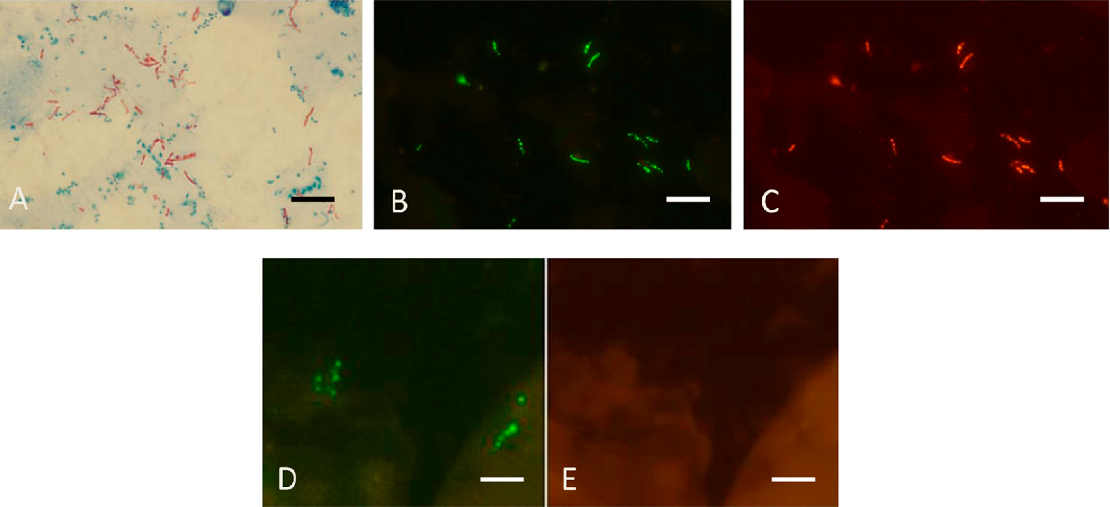
Figure 8. Sputum smears in the MN Genus-MTBC FISH test. Photographs showing dual colour fluorescence reactivity of sputum smears from patients with Mycobacterium tuberculosis and Mycobacterium abscessus infections in the MN Genus-MTBC FISH test. A shows Ziehl–Neelsen staining for acid-fast bacilli in sputum from a patient with Mycobacterium tuberculosis infection. MN Genus-MTBC FISH test results with the MN Genus- and MTBC-specific probes on the sputum of the same patient are shown in B (green fluorescence) and C (orange fluorescence), respectively. Reactions with the MN Genus- and MTBC-specific probes in the same field in a sputum smear from another patient with Mycobacterium abscessus infection are shown in D (green fluorescence) and E (orange fluorescence), respectively. Scale bars represent approximately 5 µm. Reproduced with permission under the creative commons license from Reference